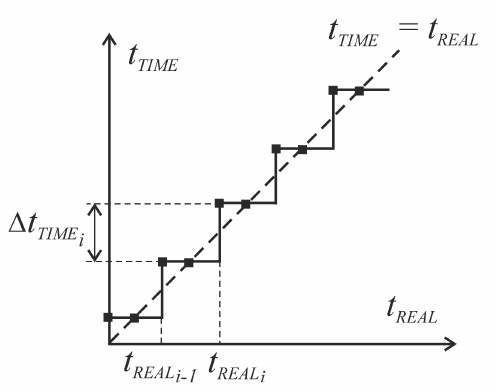
Figure 4. Approximation of timer reading values for time